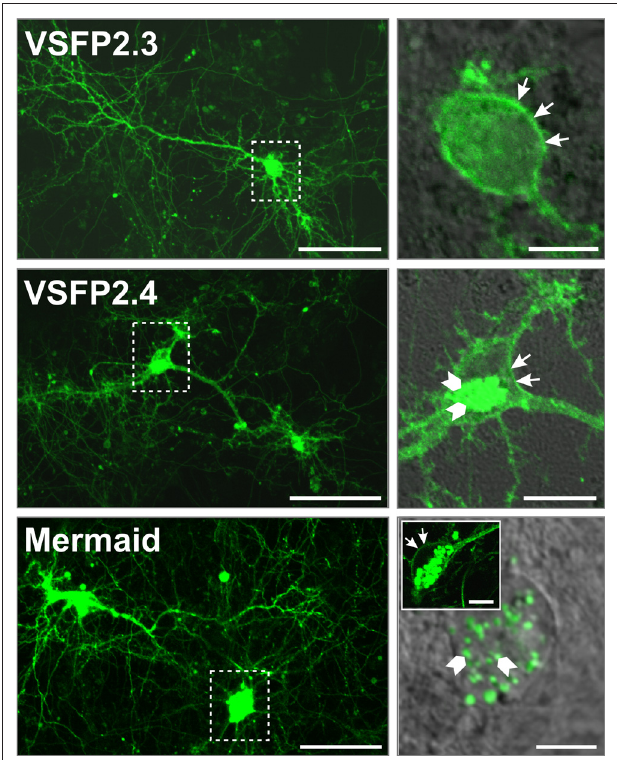
FIGURE 3 | Expression pattern of VSFP2.1 variants in transfected hippocampal neurons. Primary hippocampal cultures derived from mouse E18 embryos were transfected with either VSFP2.3, VSFP2.4 or Mermaid 6 days after plating and imaged by confocal fl uorescence microscopy 1 week later. Fluorescence was allowed to saturate locally to optimize the visualization of neuronal processes. Boxed areas in the left panel are shown magnifi ed on the right panel. Arrows indicate cell surface expression while arrowheads show intracellular expression. Note the targeting of VSFP2.3 and VSFP2.4 to the plasma membrane and Mermaid-associated intracellular aggregates in magnifi ed views. The insert in the lower right image shows an example of a cell with clear expression of Mermaid at the cell surface. Scale bars are 50 and 10 µm for left and right panels, respectively.